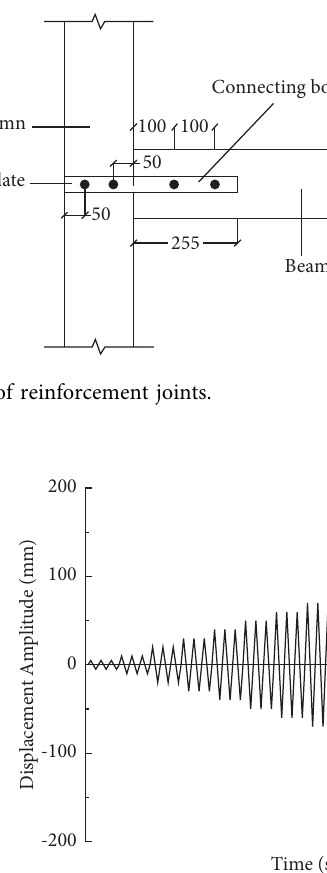
Figure 5: Loading